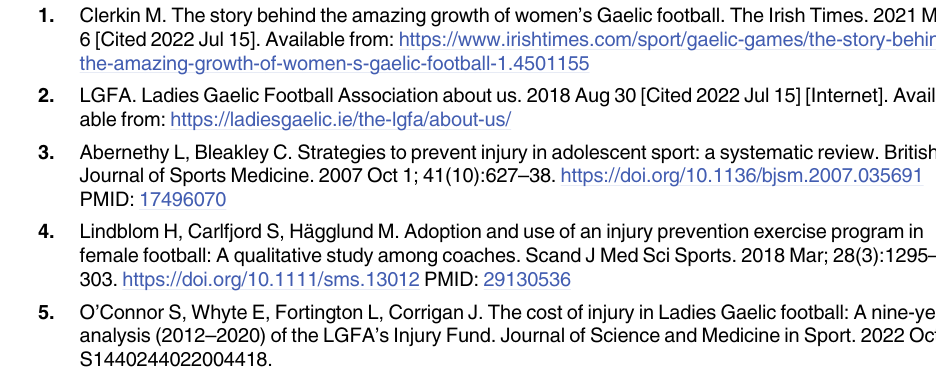
S1 Table. Standards for Reporting Qualitative Research Checklist. S2 Table. Coding